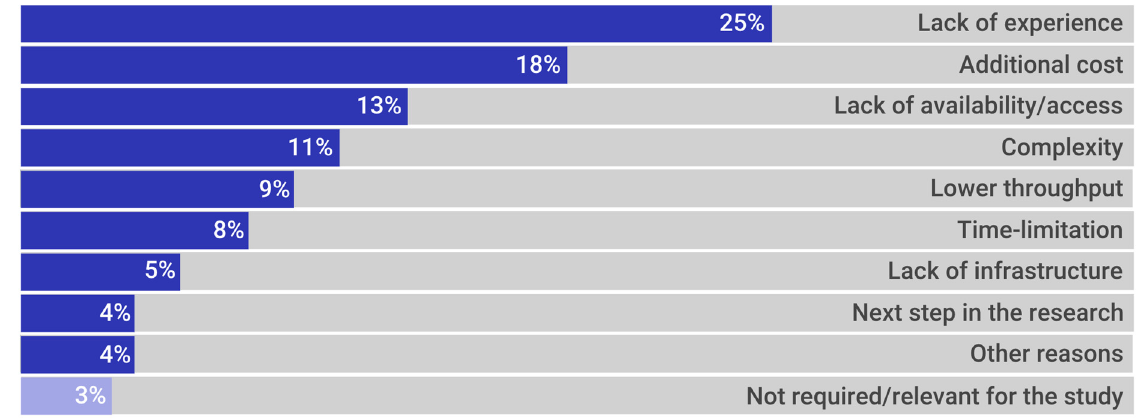
Figure 7. Principal reasons for not using 3D models (%).